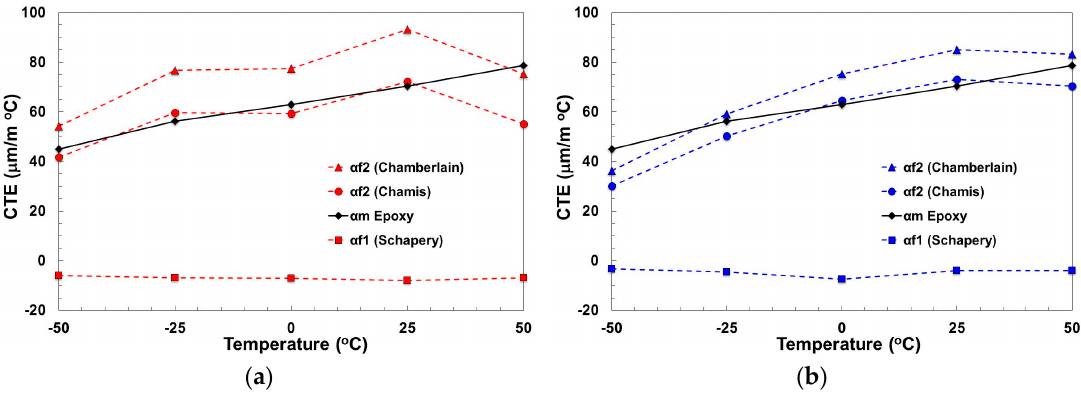
Figure 8. Comparison of resin and fibre coefficients of thermal expansion: ( a ) Flax fibres; ( b ) Sisal fibres.